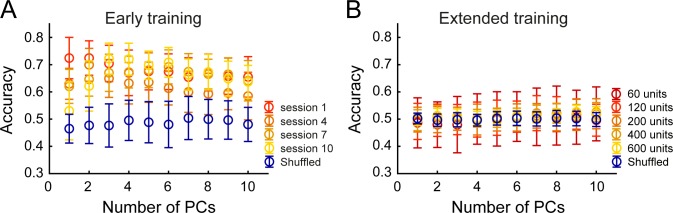
Principal Component Analysis (PCA) followed by Linear Discriminant Analysis (LDA) allows prediction of brain region identity in early training but not extended training.(A) Decoding accuracy of brain region identity as a function of the number of principal components (PCs) included in the analysis, during four selected early training sessions. Mean accuracy (± s.d.) in each condition was compared to chance (blue – shuffled condition for session 10) (B) Decoding accuracy of brain region identity as a function of the number of principal components (PCs) included in the analysis, and across different ensemble sizes, during extended training. Mean accuracy (± standard deviation) in each condition was compared to chance (blue – shuffled condition for 600 units).